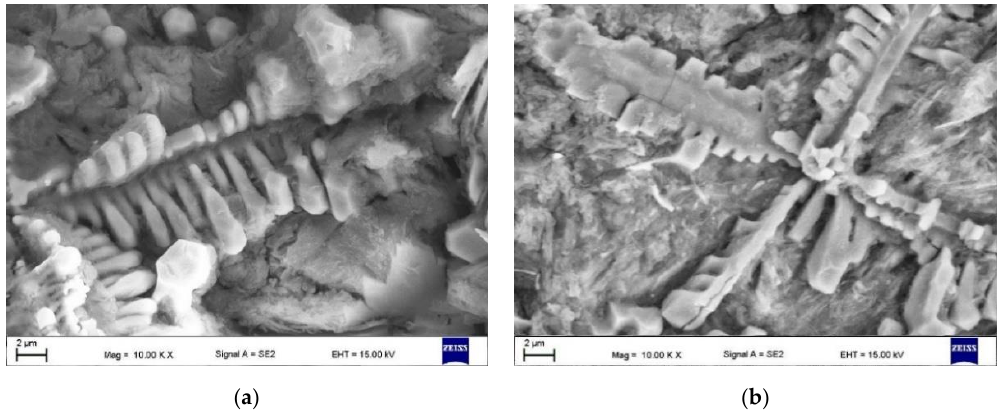
Figure 12. SEM micrographs of deep-etched ( a ) TRC and ( b ) TRM showing primary dendritic precipitates of TiC and (Ti, Mo)C phases, respectively (Table 3).